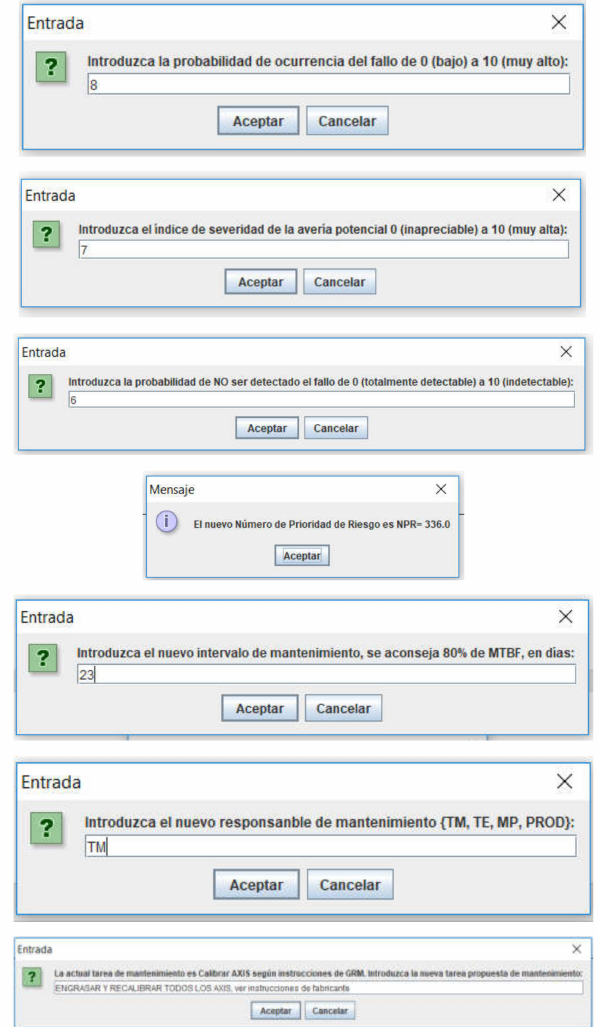
Figure 9. Data review windows for the new chosen case using questions from the operational context.